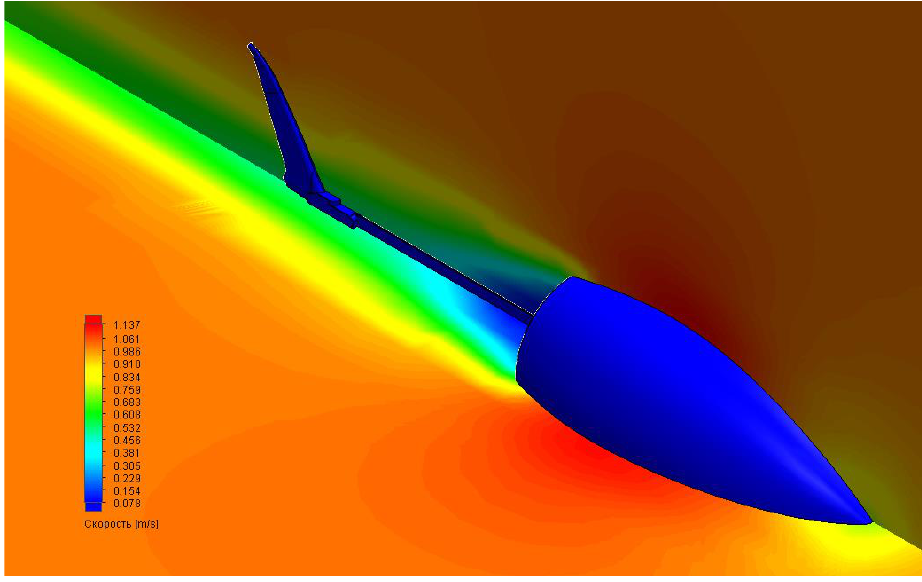
Figure 3. Simulation of body resistance profile of the 3D fish robot movement in an aquatic medium with constant flow. Color grade corresponds to values of the flow speed.